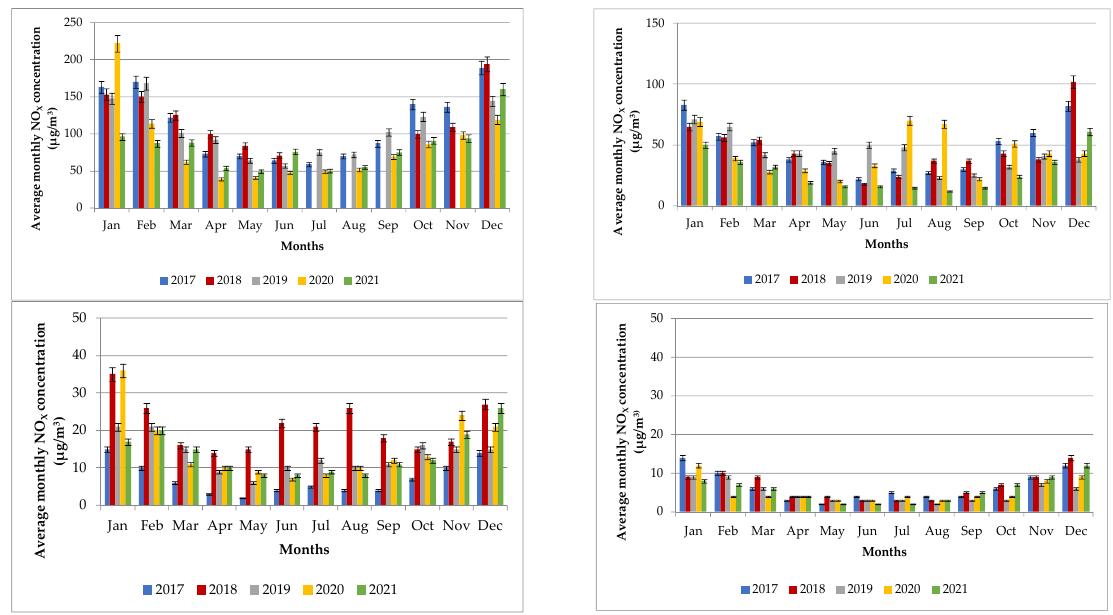
Figure 6. Average monthly NO X concentrations at locations A, B, D, and E between 2017 and 2021 (from left to right, from top to bottom).